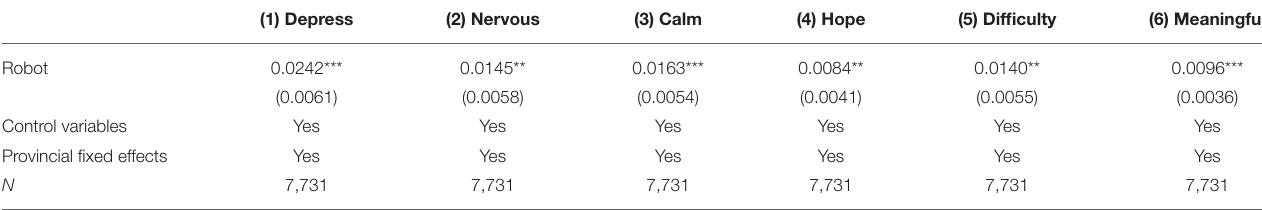
TABLE 6 | Robustness test: changing the level of clustered standard errors.